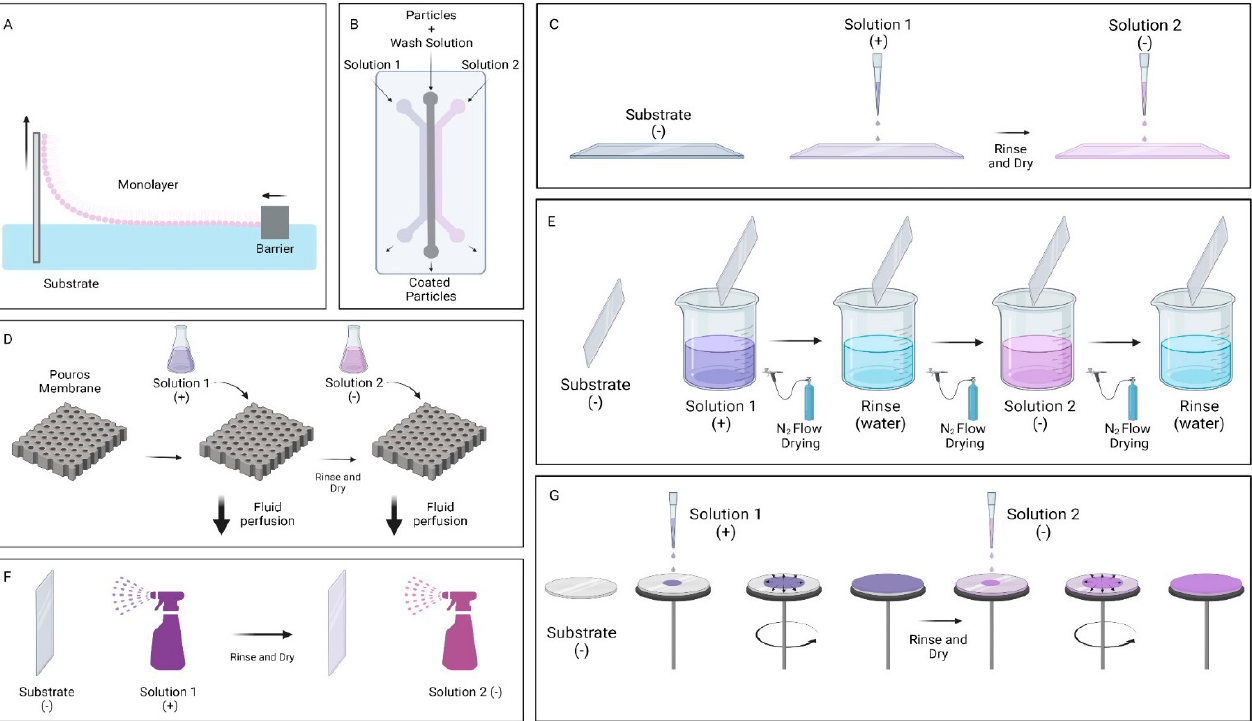
Figure 2. Schematics of the different LbL assembling methods. ( A )—Langmuir–Blodgett assembly; ( B )—microfluidics; ( C )—drop coating; ( D )—perfusion, ( E )—dip coating; ( F )—spray coating; ( G )—spin coating. Figure created with BioRender.com.